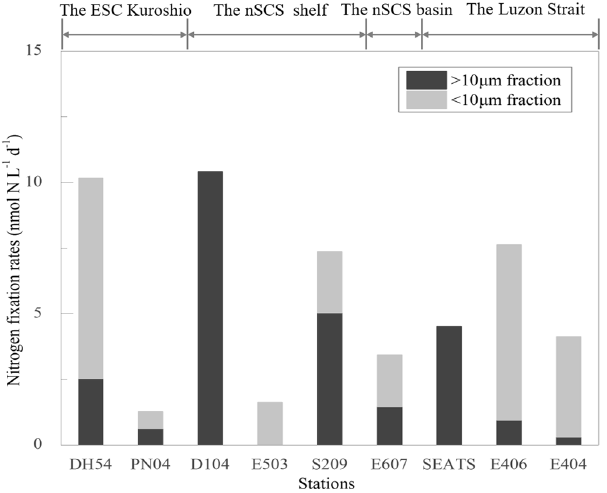
Figure 2. Distributions of N 2 fixation activity of the whole-water sample (open circle) and < 10 μ m fractions (solid circle) at the surface. Note for software: Origin 8.5 PRO (http://www.originlab.com/).